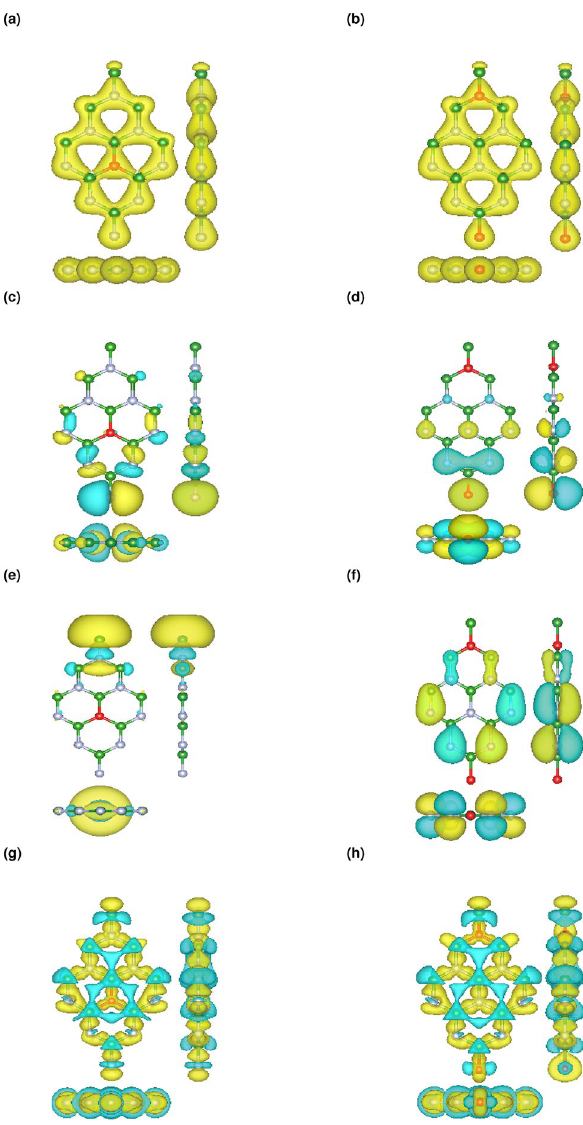
Figure 6. ( a , b ) Top and side views of total charge density for (cid:31) = 5.5 and 11% Oxygen doped hBN. ( c , d ) Top and side views of charge density at VBM for (cid:31) = 5.5 and 11% Oxygen doped hBN. ( e , f ) Top and side views of charge density at CBM for (cid:31) = 5.5 and 11% Oxygen doped hBN. ( g , h ) Top and side views of charge density difference for (cid:31) = 5.5 and 11% Oxygen doped hBN. The yellow regions indicate the positive value (electron accumulation) whereas, the cyan regions represent the negative values (electron depletion) The isosurface of 3 charge densities is equal to 0.01 e/Å